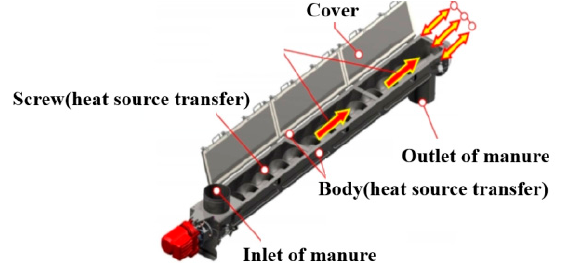
Figure 4. Structure of screw-type dryer.